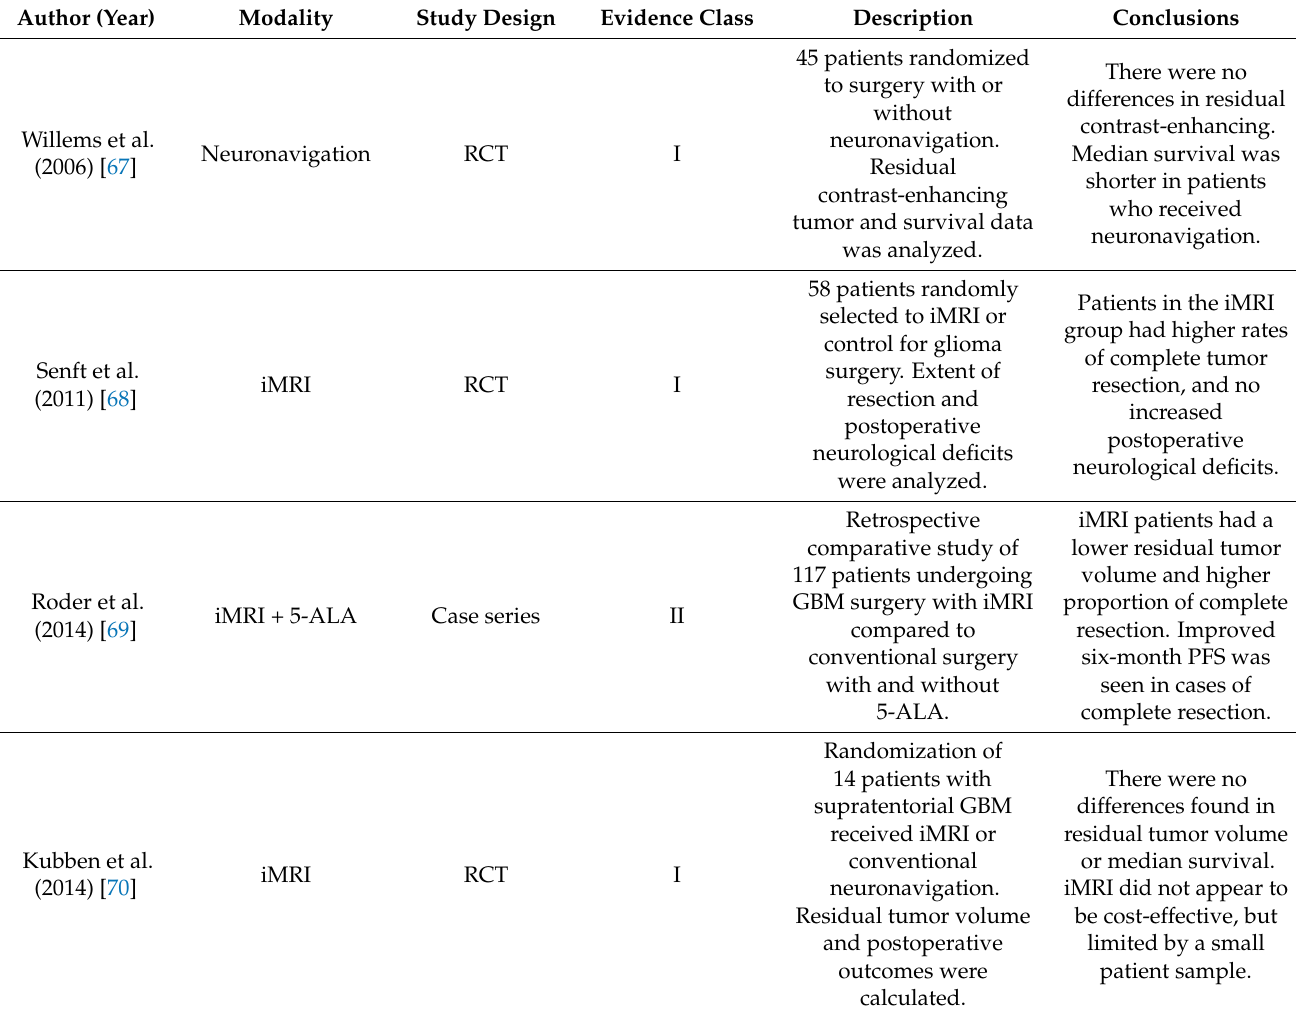
Table 2. Intraoperative image guidance for high-grade glioma evidentiary